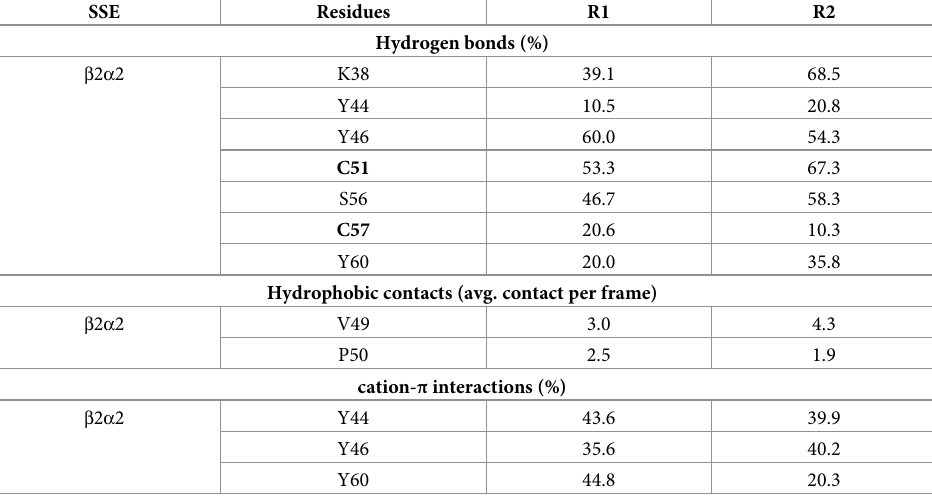
Fig 8. Binding of R44Y/S60Y St_ β IB1 to a POPC Bilayer. A) Simulation snapshots. B) Electron density plot for R44Y/S60Y St_ β IB1 and the POPC bilayer for two replica (solid lines and dashed lines). C) Bound protein orientation. D) Depth of anchorage. The depth is calculated for each amino acid as the distance between its C-alpha and the phosphate plane in the last frame of simulation (relevant values are given in Table A in S2 Text). https://doi.org/10.1371/journal.pcbi.1009871.g008 Table 5. Inventory of interactions between R44Y/S60Y St_ β IB1 and a POPC bilayer. Hydrophobic contacts are given as average number of contacts per frame. Hydrogen bonds and cation- π occupancies are shown in percentages. Residues in bold indicate hydrogen bonds involving the amino acid